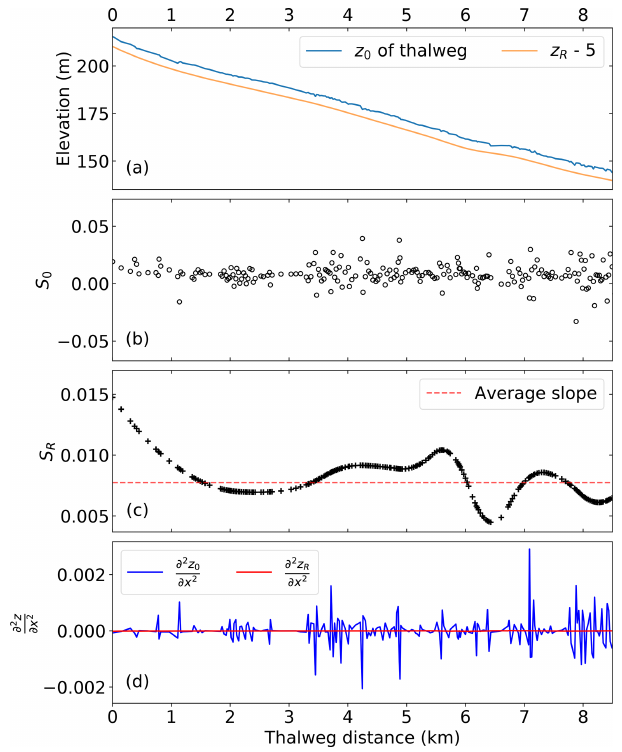
Figure 11. Waller Creek bottom elevation and slope: (a) z elevation, with 5m subtracted from z R for clarity; (b) S 0 thalweg slope be- tween cross sections; (c) S R smoothed bottom slope; and (d) second derivative of z 0 and z R . Note the y -axis scaling in (c) has reduced limits compared to (b) to better show the smoothness achieved by the spline